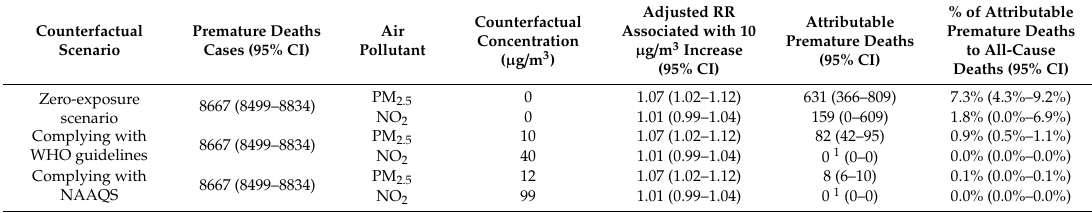
Table 2. Premature deaths attributable to air pollution in